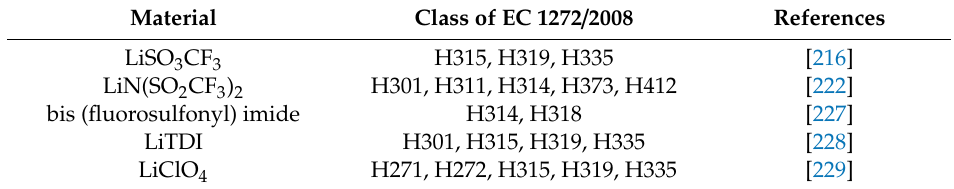
Table 7. Hazard statements of LiSO 3 CF 3 , LiN (SO 2 CF 3 ) 2 , bis (fluorosulfonyl) imide, LiTDI, and LiClO 4